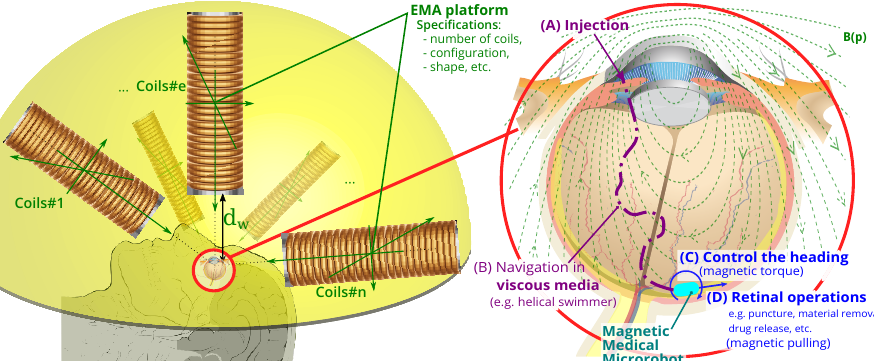
Figure 2. Illustration of the ophthalmic microrobotic MIS system: ( left ) the EMA platform that should respect the geometry of the human head and be arranged in the yellow hemisphere; ( right ) the ophthalmic microrobotic MIS procedure where biomedical mirorobot is injected by a surgeon and controlled by the EMA setup; the generated magnetic field and gradient induce the magnetic torque and pulling force in the medical microrobot for the different steps of the